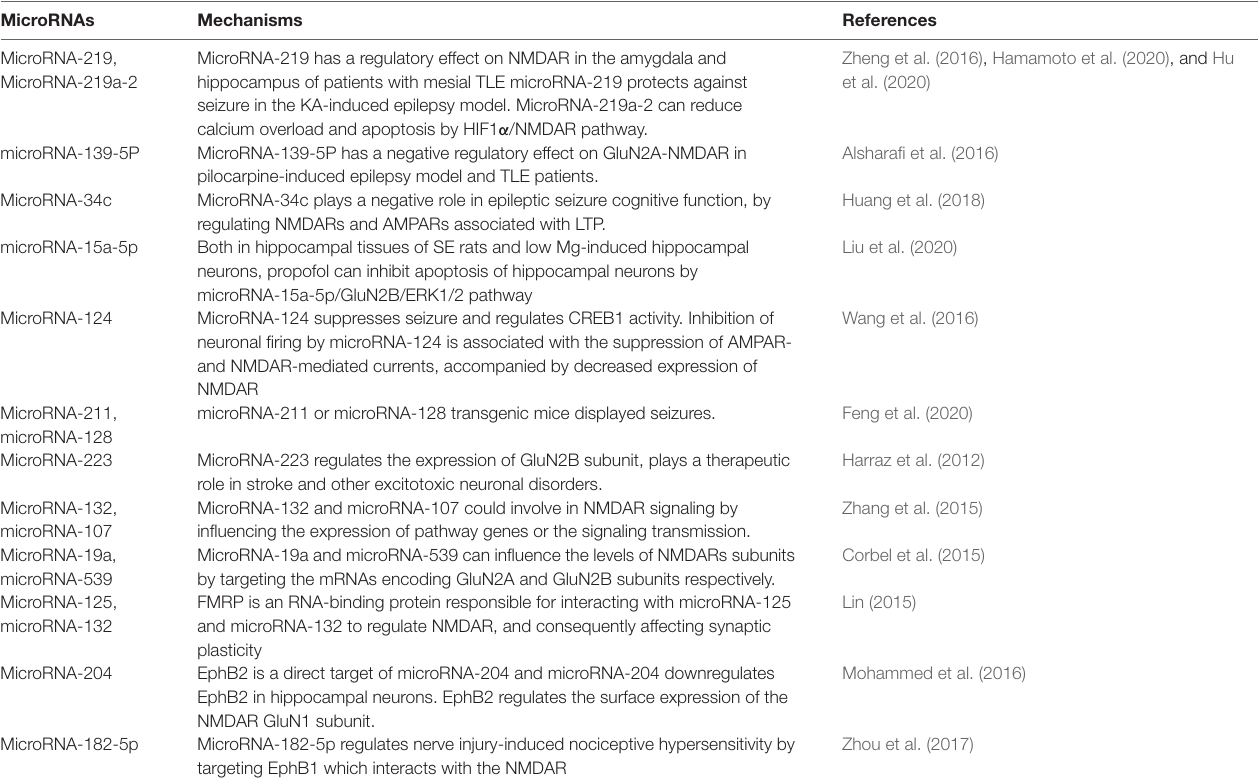
TABLE 2 | Regulation of microRNAs on NMDARs in nervous